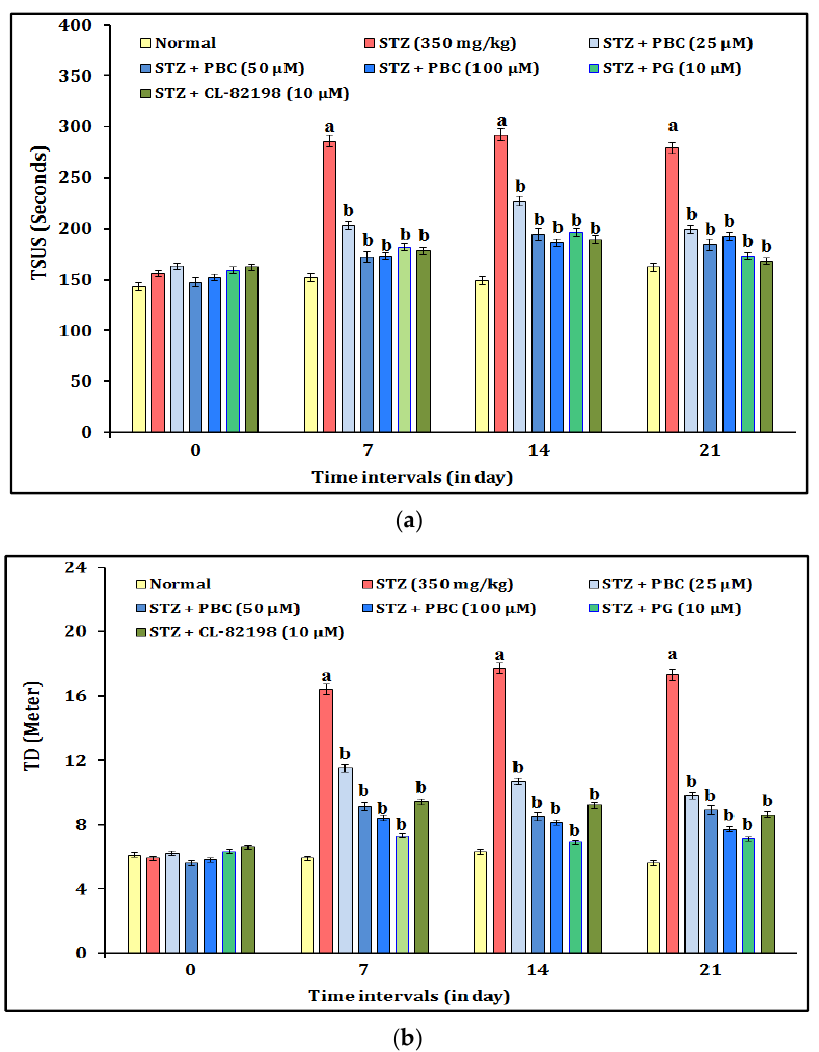
Figure 2. ( a ) Effect of PBC in DNP-induced TSUS changes in chemical pain sensation. Data are ex- pressed as mean ± SD, n = 20 zebrafish per group. Abbreviation: CL-82198, MMP-13 inhibitor; PG, pregabalin; SS, swimming speed; STZ, streptozotocin; TSUS, time spent in the upper segment. ( b ) Effect of PBC in DNP-induced TD changes in chemical pain sensation. Data are expressed as mean ± SD, n = 20 zebrafish per group. Abbreviation: CL-82198, MMP-13 inhibitor; PG, pregabalin; SS, swimming speed; STZ, streptozotocin; TD, travel distance. a p < 0.05 vs. normal group. b p < 0.05 vs. STZ control group.